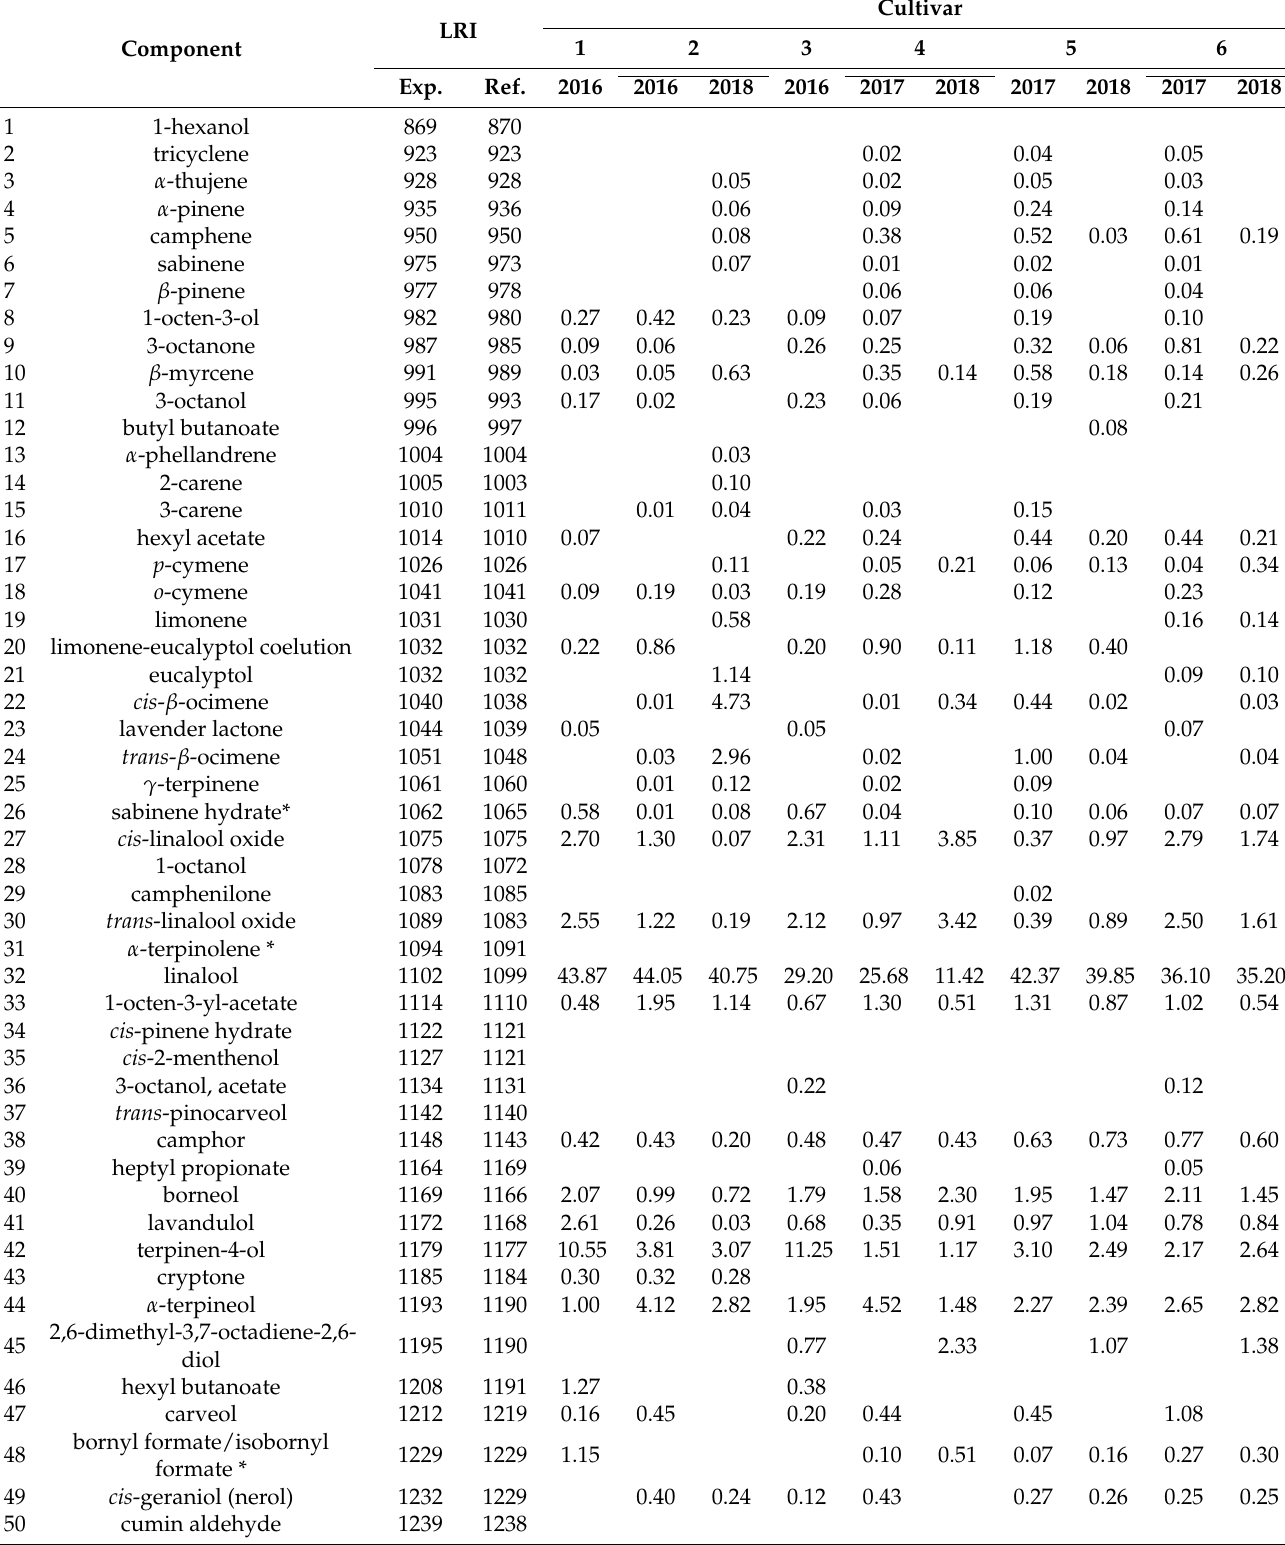
Table 1. GC data for essential oil components identified in the samples from the different L. angustifolia cultivars (1–6). Apart from LRI (experimental and reference values), all the figures represent % abundance (area percent without solvent peak). * tentative